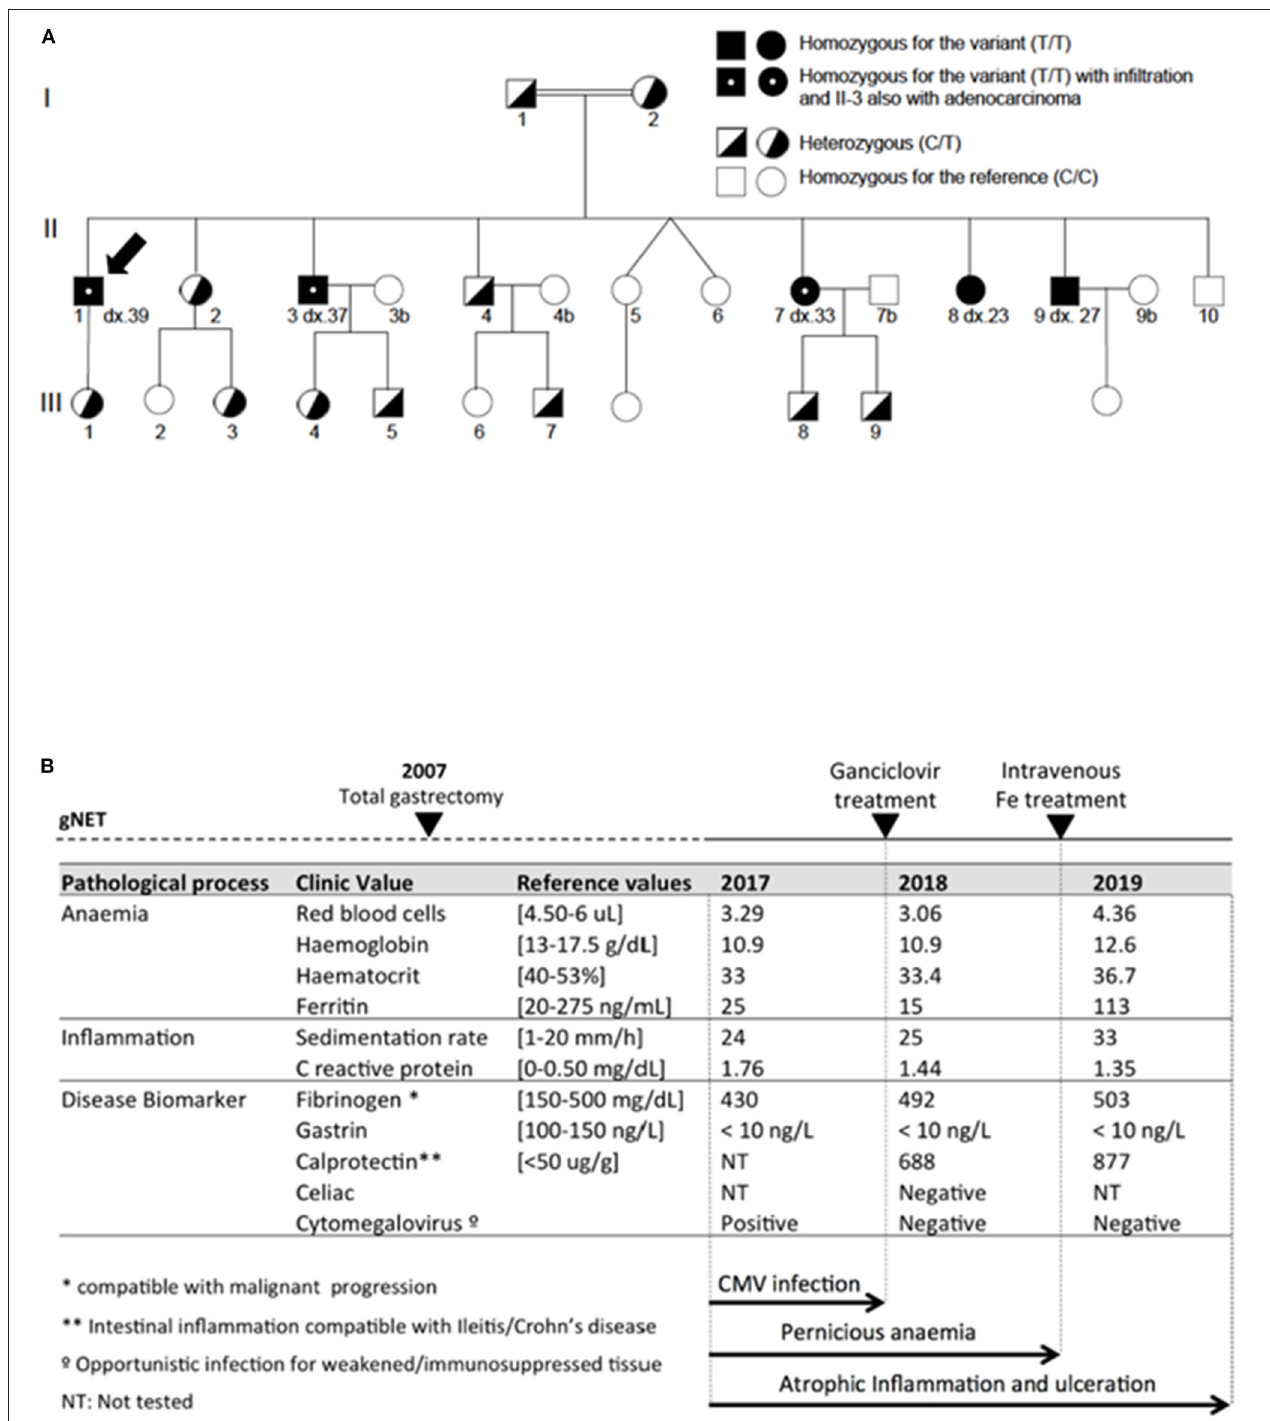
FIGURE 1 | (A) Pedigree of studied family with complete segregation of the ATP4A p.R703C mutation (C: Reference allele for the position; T: Alternative allele for the position). Black arrow shows the proband evaluated in this study. (B) Serologic information of proband patient regarding anemia, inflammation and disease markers measured in 2017, 2018, and 2019. CMV infection was eradicated after ganciclovir treatment. Anemia markers become partially restored after Fe treatment. Atrophic inflammation persisted in the 2019 evaluation.